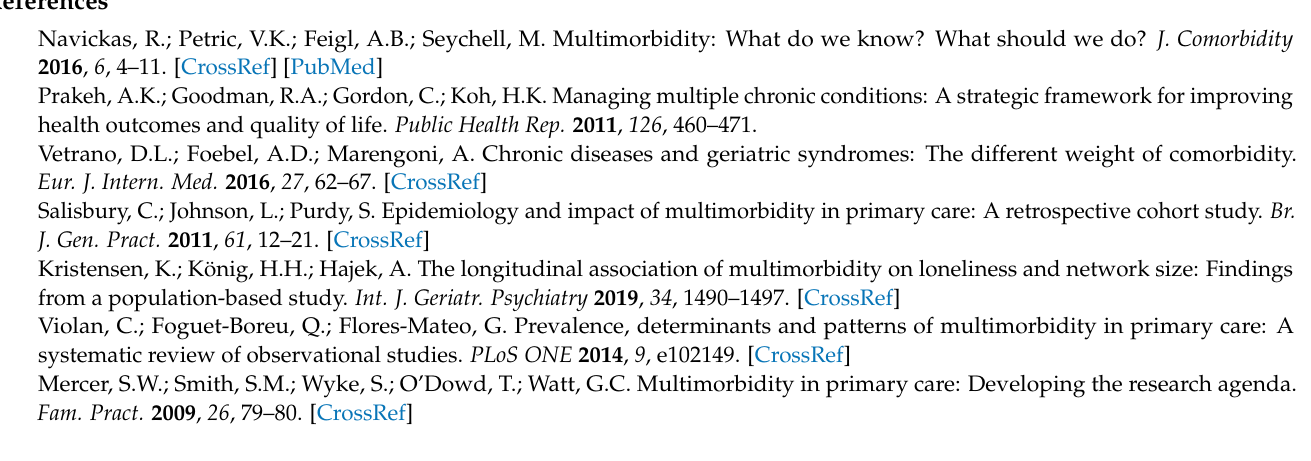
Table S2: Coefficients (dependent variable: SWB); Table S3: Coefficients (dependent variable: EWB); Table S4: Coefficients (dependent variable: